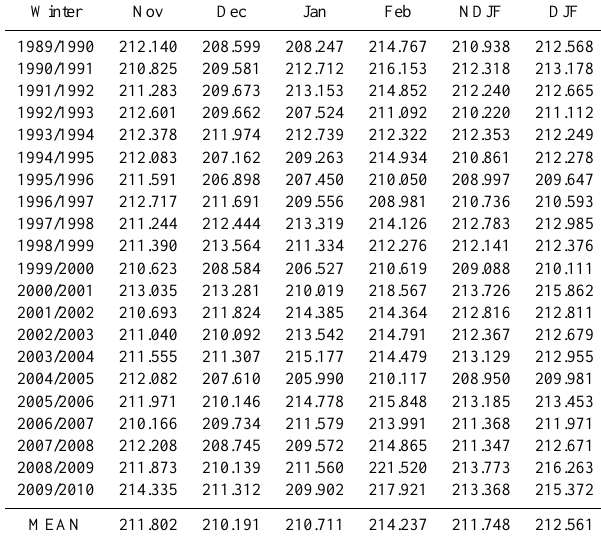
Fig. 7. Anomaly patterns of the geopotential height (m; color shaded) and the monthly mean geopotential height (m; solid lines) Figure 7: Anomaly patterns of the geopotential height (m; color shaded) and the monthly 5 at the 50hPa surface for December 2009, January, February, and mean geopotential height (m; solid lines) at the 50 hPa surface for December 2009, January, 6 March 2010, respectively. Data: ERA-Interim analyses interpolated February, and March 2010, respectively. Data: ERA-Interim analyses interpolated on a 7 on a regular 1 × 1 ◦ latitude/longitude regular 1 ° x 1 ° latitude/longitude grid 8